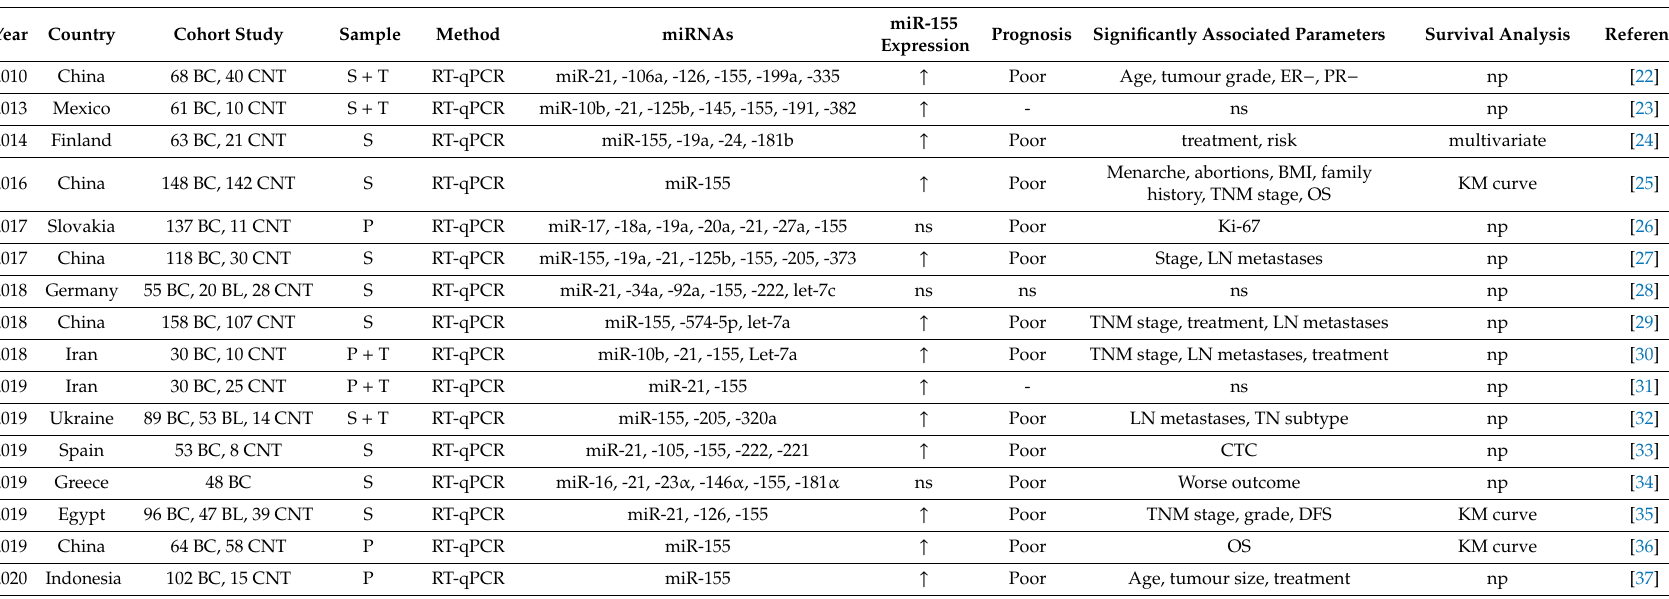
Table 2. Comprehensive characteristics of selected studies and association between circulating miR-155 and prognostic characteristics in